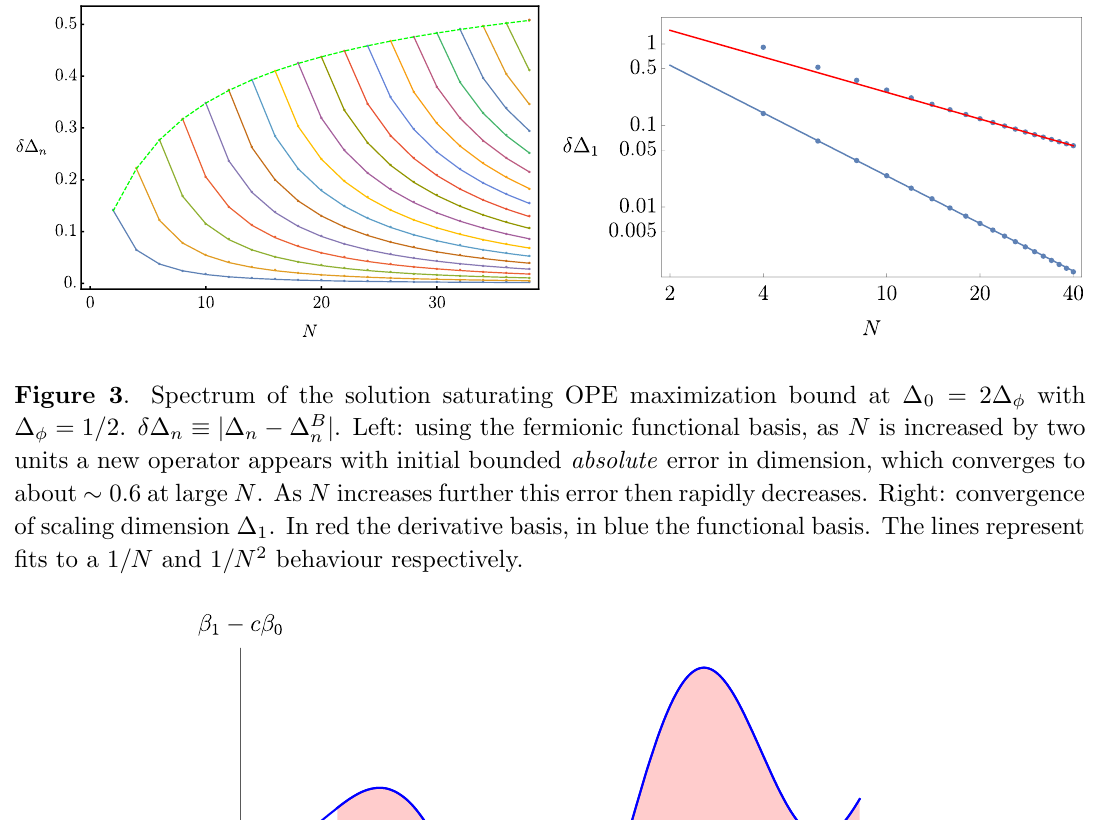
Figure 4 . The single bin functional [ , here shown for (cid:1) (cid:30) = 1 region where the functional is negative must cancel those where it is positive. Given our gap assump- tions on the extremal solution, this implies an operator must appear between 2(cid:1) (cid:30) +1 and 2(cid:1) (cid:30)